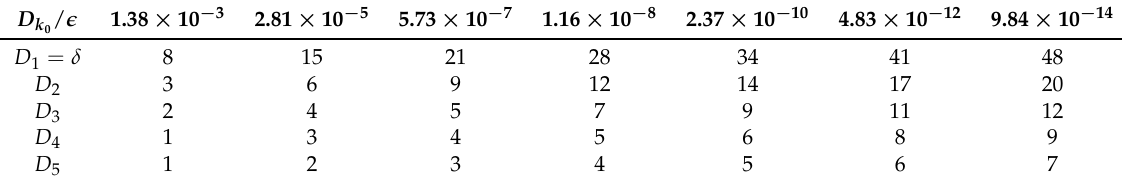
Table 3. Subdivision depth of 3-point interpolating ternary subdivision curves.